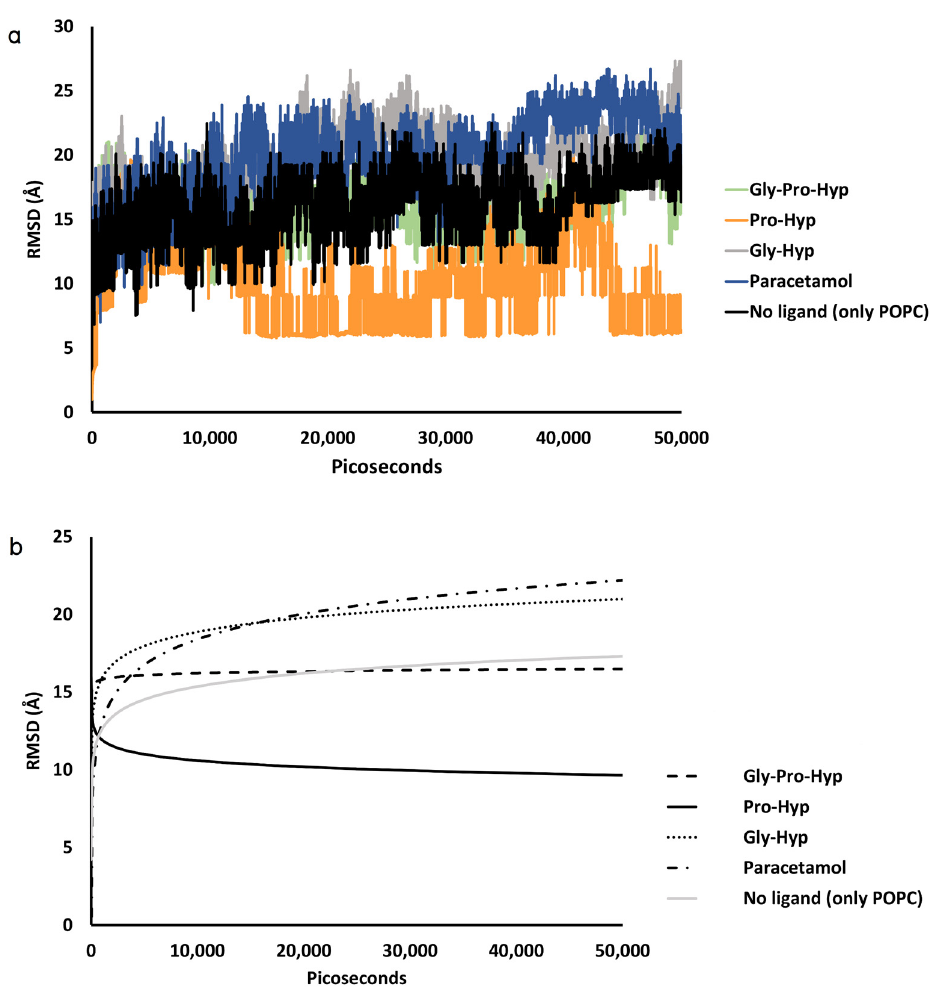
Figure 10. Root mean square deviation (RMSD) values of the membrane coordinates of ( a ) Gly-Pro-Hyp, Pro-Hyp, Gly-Hyp, paracetamol -POPC bilayer models, and pure POPC bilayer model, and ( b ) non-linear fits during the 50,000 ps simulations.